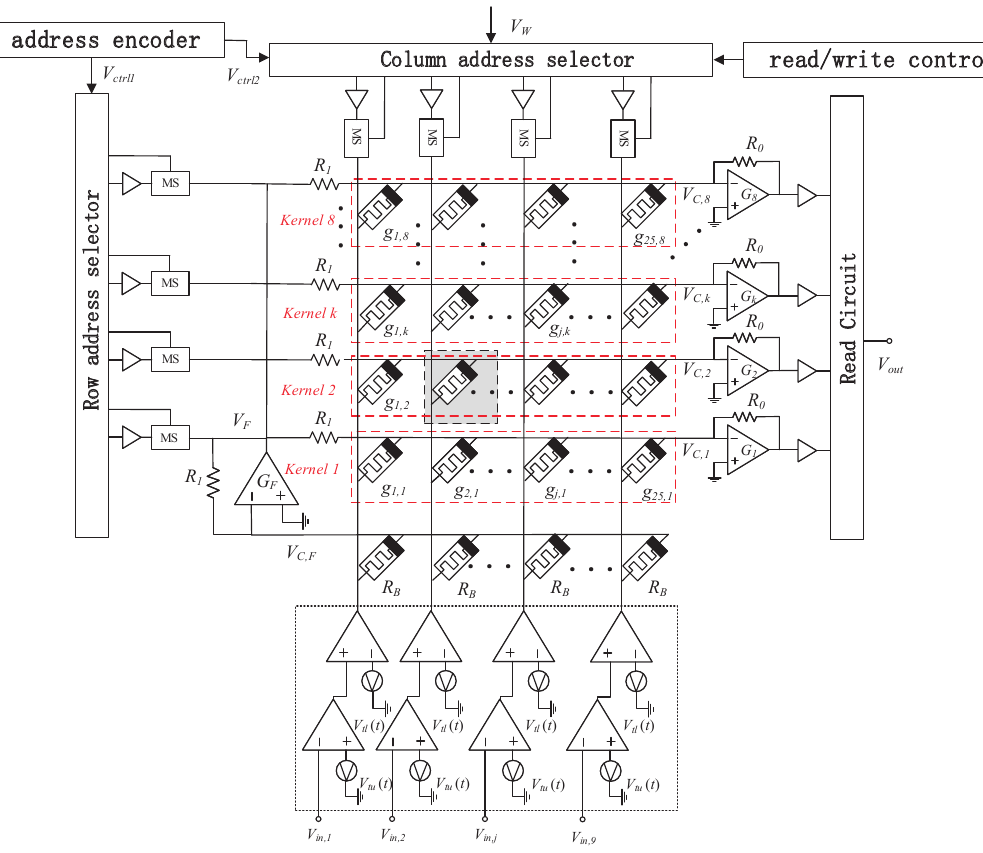
Figure 9. A memristor cross-array circuit for convolution operation. The dashed box is the weighted average